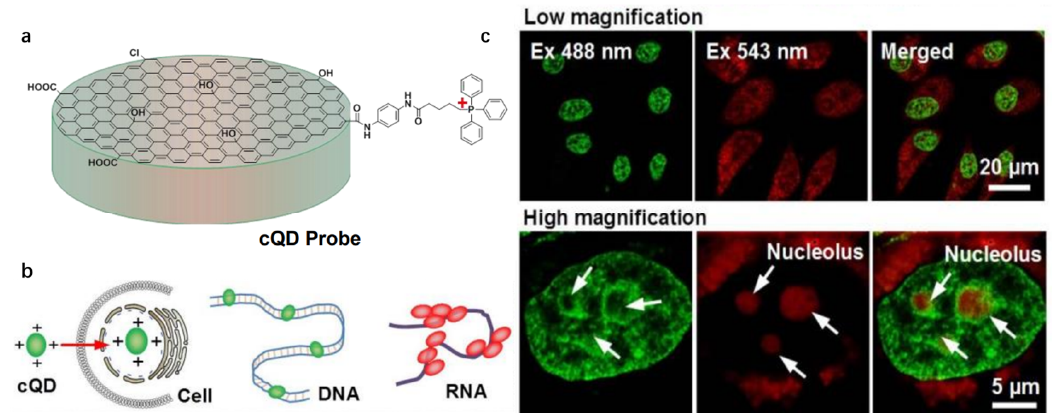
Figure 11. ( a ) The structure of the cQD probe. ( b ) Schematic drawing of the cQD probe interactions with intracellular DNA and RNA. cQD confined by dsDNA emits green fluorescence, and cQD clustered by ssRNA emits red fluorescence. ( c ) cQD-loaded HeLa cells simultaneously excited with 488 and 543 nm (emission windows of 500–560 nm and 570–650 nm, respectively). Reproduced from [44] with permission from John Wiley and Sons, Copyright 2019.